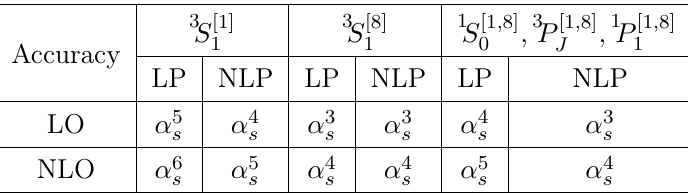
of various Fock states T ( (cid:11) 5 ) , the s O